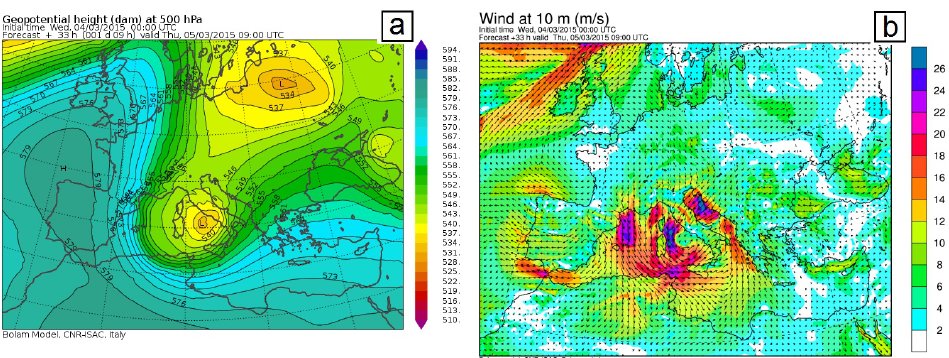
Figure 8. 5 March 2015 09:00 UTC: ( a ) Geopotential height (dam) at 500 hPa; ( b ) Wind (m/s) at 10 m (Bolam